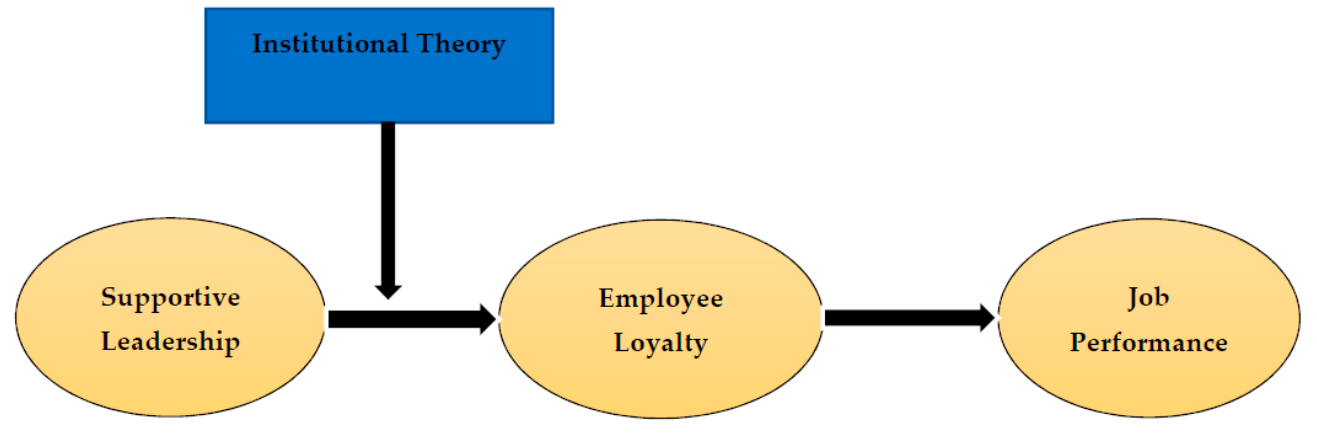
Figure 1. Proposed Theoretical